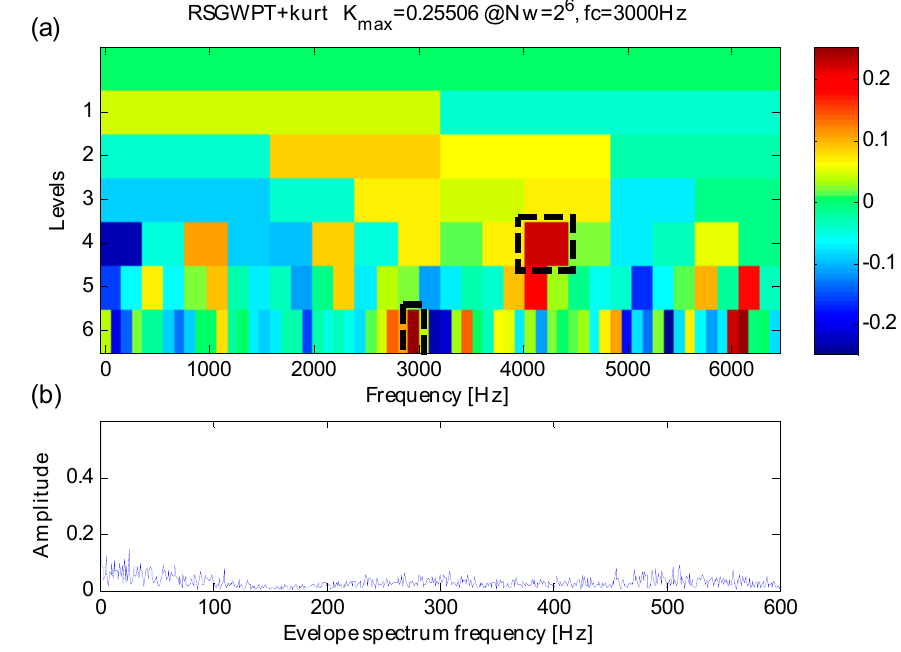
Figure 8. ( a ) The results of kurtogram; ( b ) trhe results of envelope spectrum.